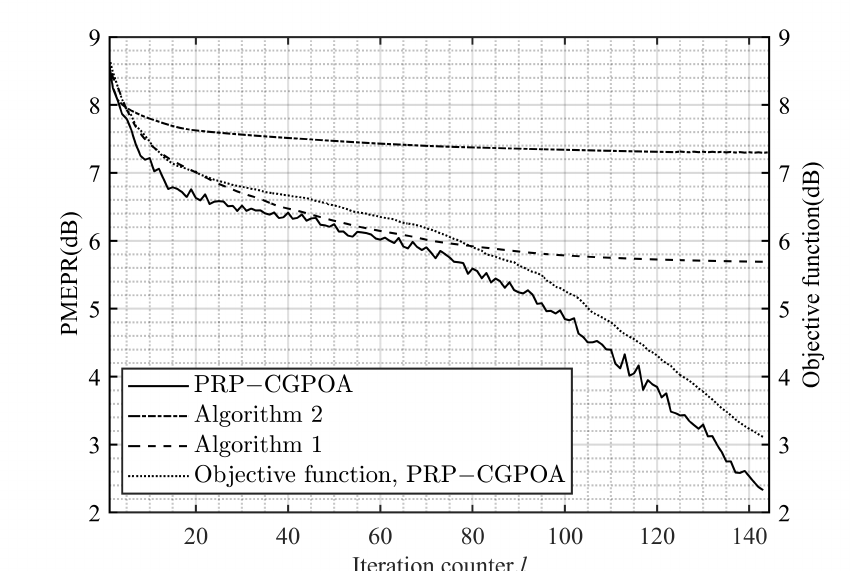
Figure 4. PMEPRs and objective function in (10) versus the iteration numbers, where Algorithm 1 is from [19] and Algorithm 2 is from